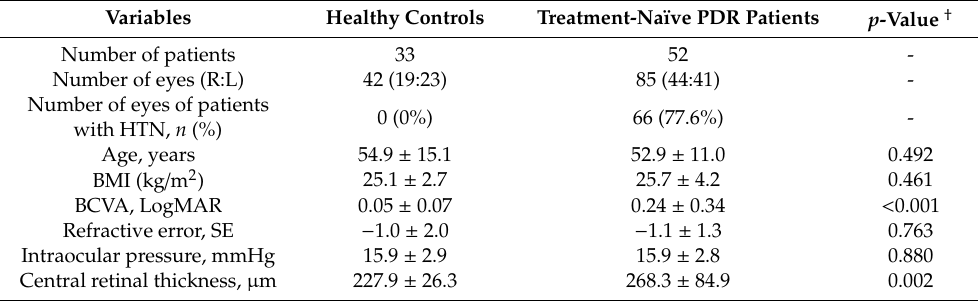
Table 1. Baseline characteristics of the treatment-naïve proliferative diabetic retinopathy patients and the healthy